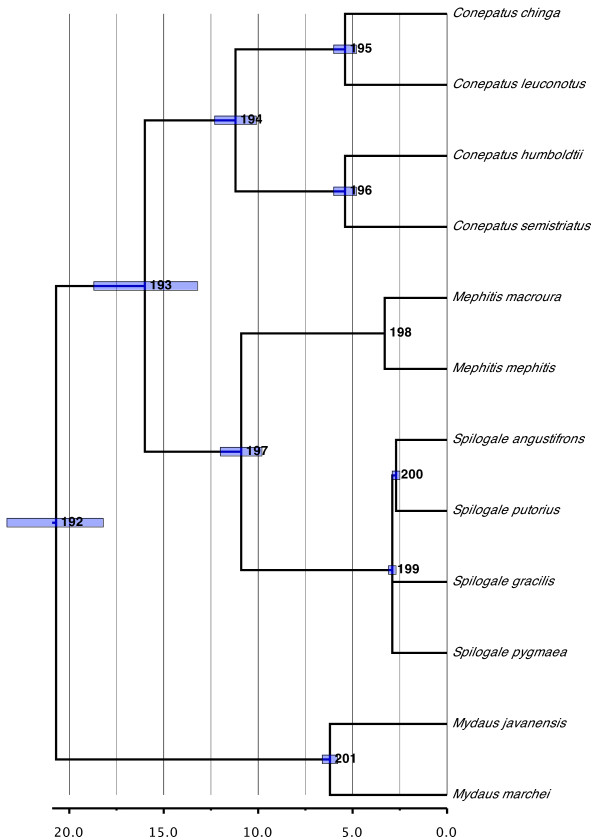
Phylogenetic relationships and divergence times estimates within Mephitidae. Nodes are individually numbered, with node bars indicating 95% confidence intervals on the divergence time estimates (in Ma before present).